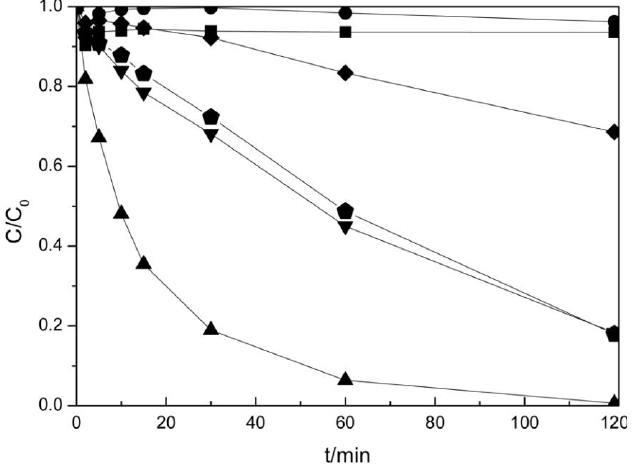
Figure 13. OMA removal by ozonation ( ◼ ), photolysis ( ● ), photochemical ozonation ( ♦ ), and pho- tocatalytic ozonation using g-C 3 N 4 ( ▼ ), g-C 3 N 4 -500 ( ▲ ) and TiO 2 ( ⬟ ). Reproduced with permission